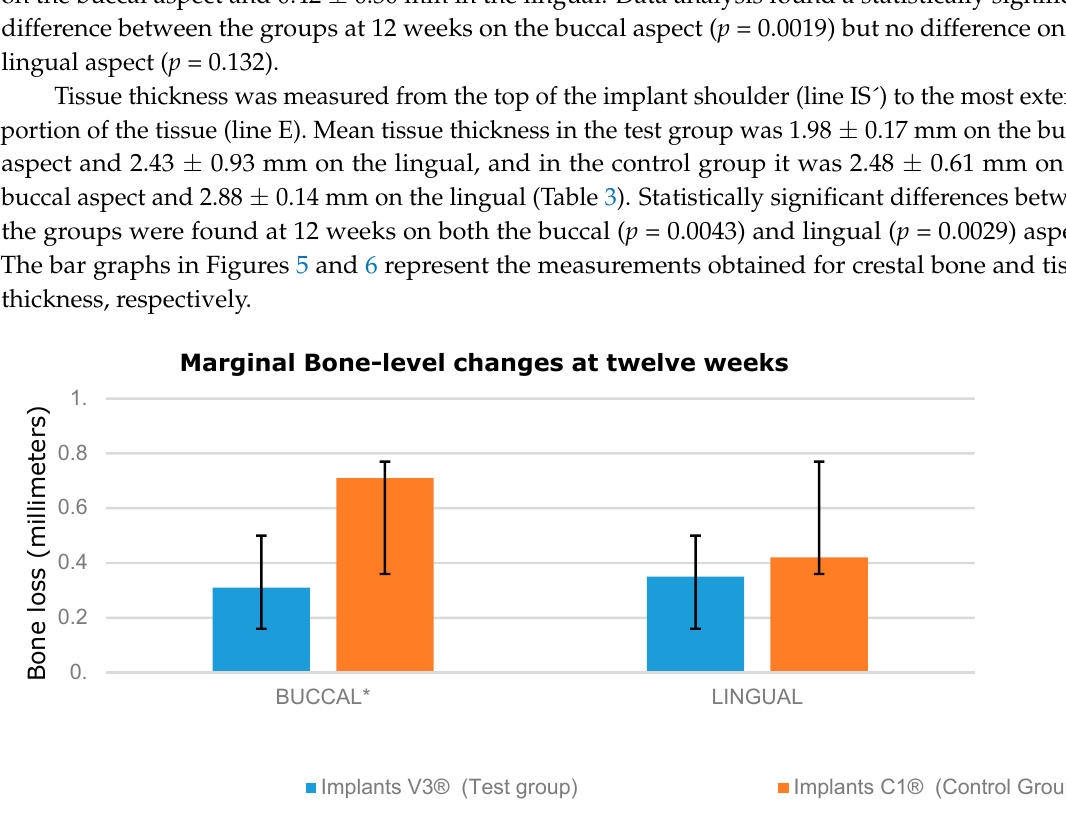
Figure 5 . Marginal bone-level changes between baseline and 12-week study times. Marginal bone loss (mean ± SD); * indicates significant differences ( p < 0.05).